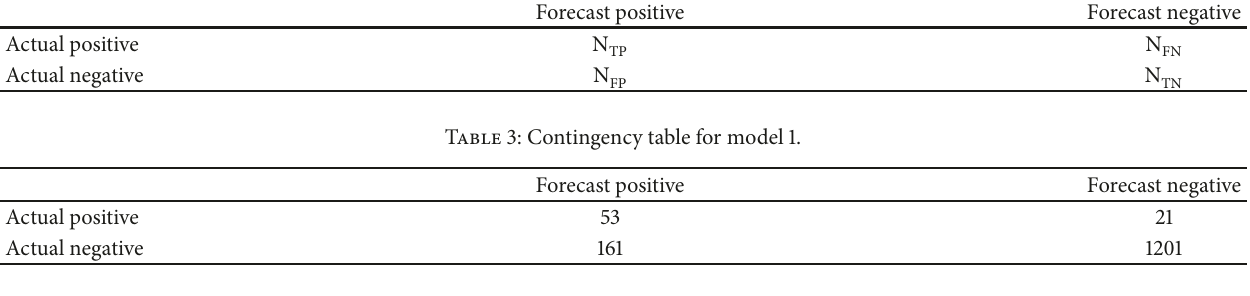
Table 4: Contingency table for model 2.